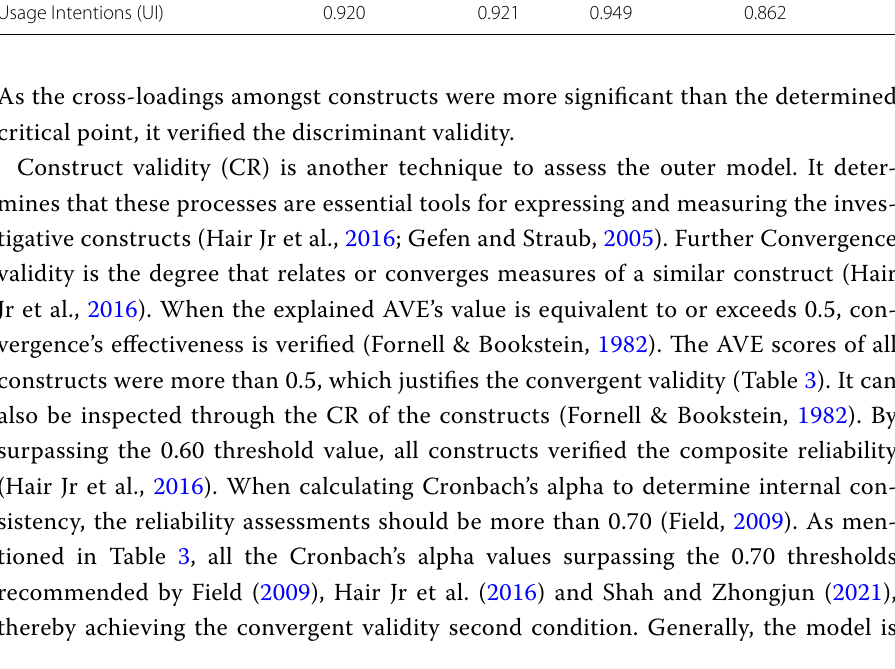
Cronbach’s Alpha